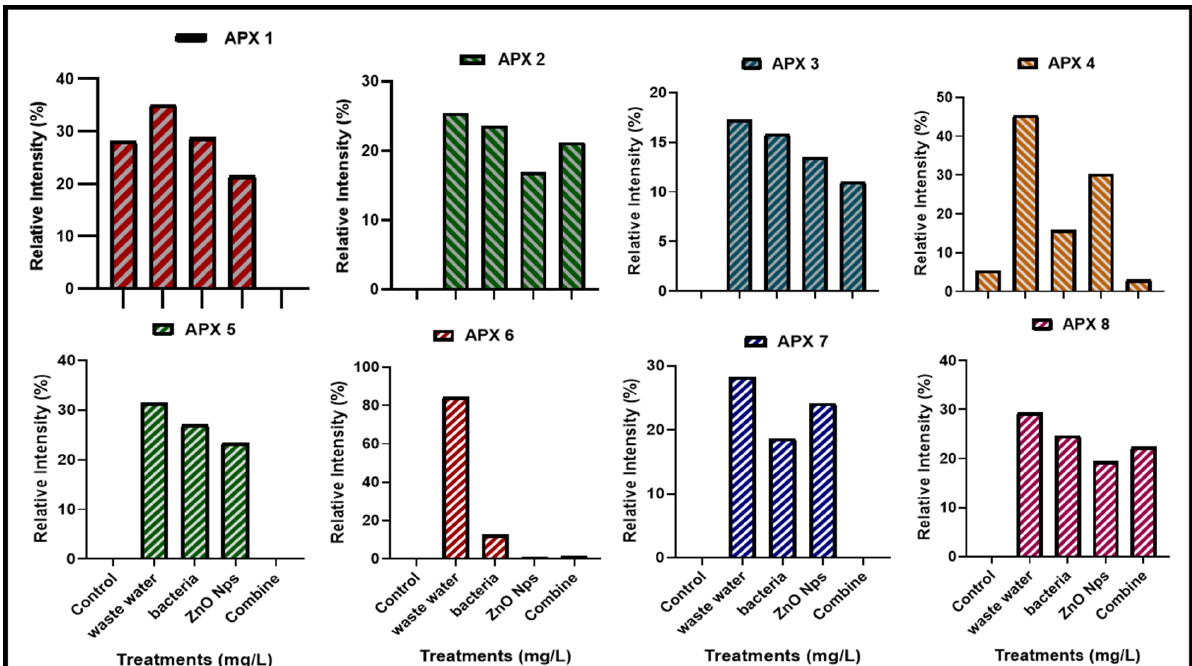
Figure 10. The relative intensity (%) of Ascorbate peroxidase (APX) gene family of rice plants that were grown by the synergistic treatment of bacteria-primed seeds that were grown in 5 mg/L of ZnO NPs and HMs-contaminated water. The treatments are DW (distilled water), w.w (Wastewater), bio-priming ( Bacillus cereus + w.w), ZnO NPs treatment (5 mg/L + w.w), and combined treatments ( Bacillus cereus + 5 mg/L ZnO NPs + w.w).